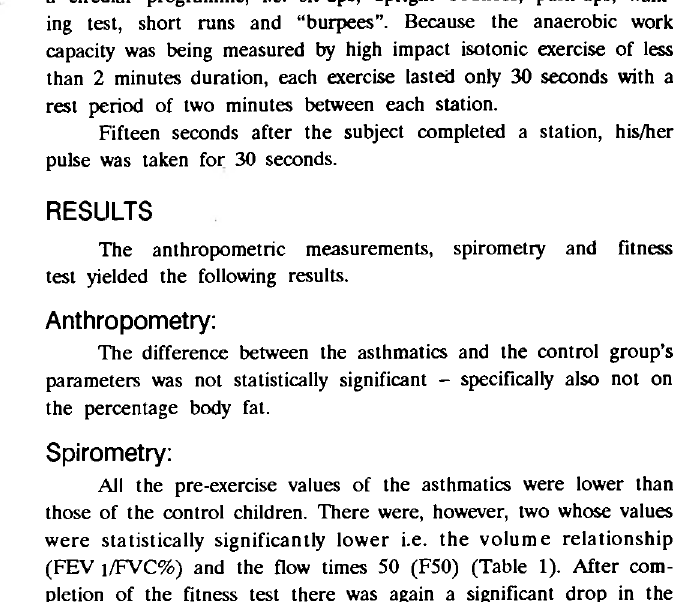
TABLE 2: SPIROMETRY AFTER EXERCISE (pre-post)